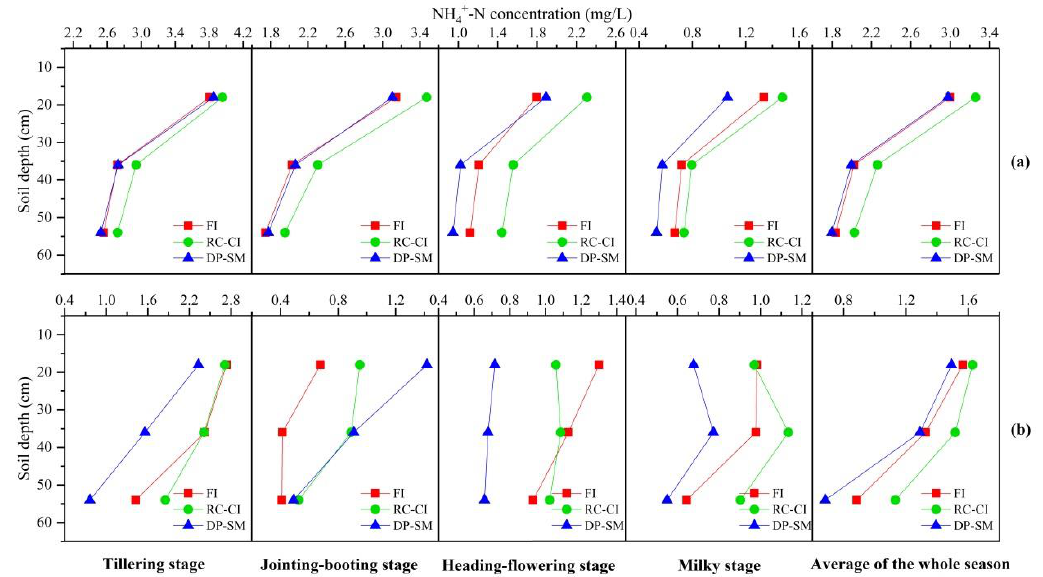
Figure 4. Vertical change of NH 4 + -N concentration in soil water at the depth of 18, 36 and 54 cm in ( a ) 2017 and ( b ) 2018.